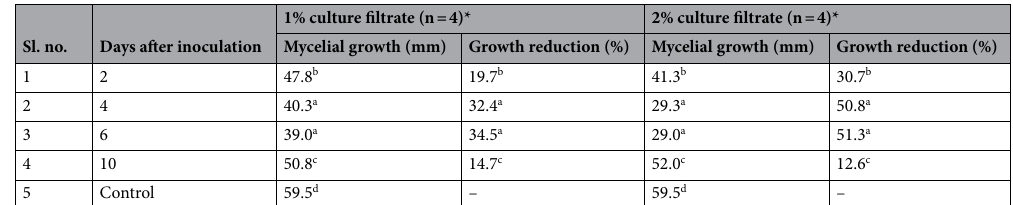
Table 1. Efficacy of culture filtrates of T. virens on the mycelial growth inhibition of M. phaseolina. In the column, mean values followed by a common letter are not significantly different (p ≤ 0.05, DMRT analysis). *Values are means of four replications.